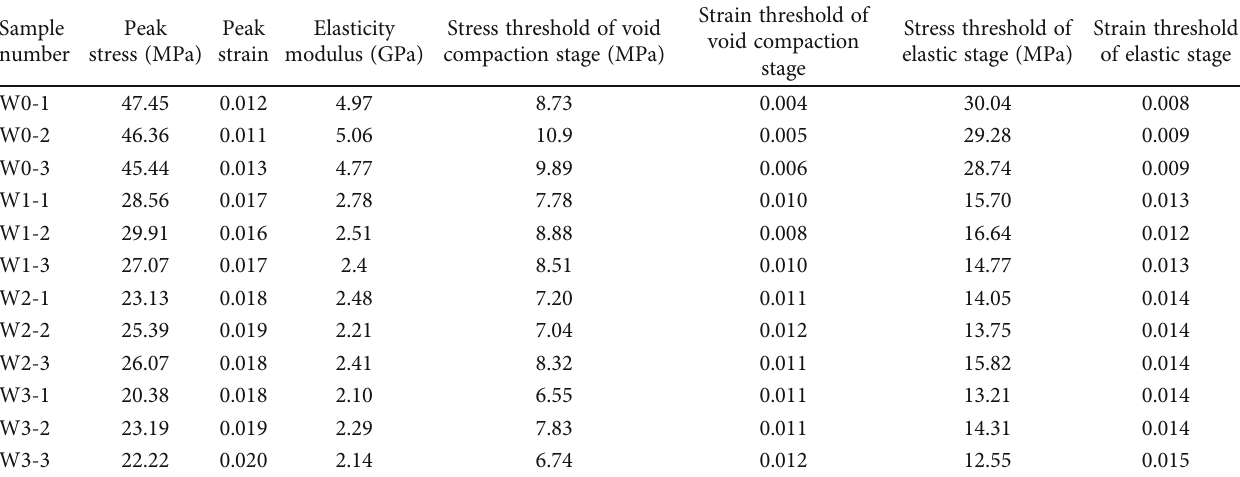
Table 2: Mechanical parameters of rock samples.